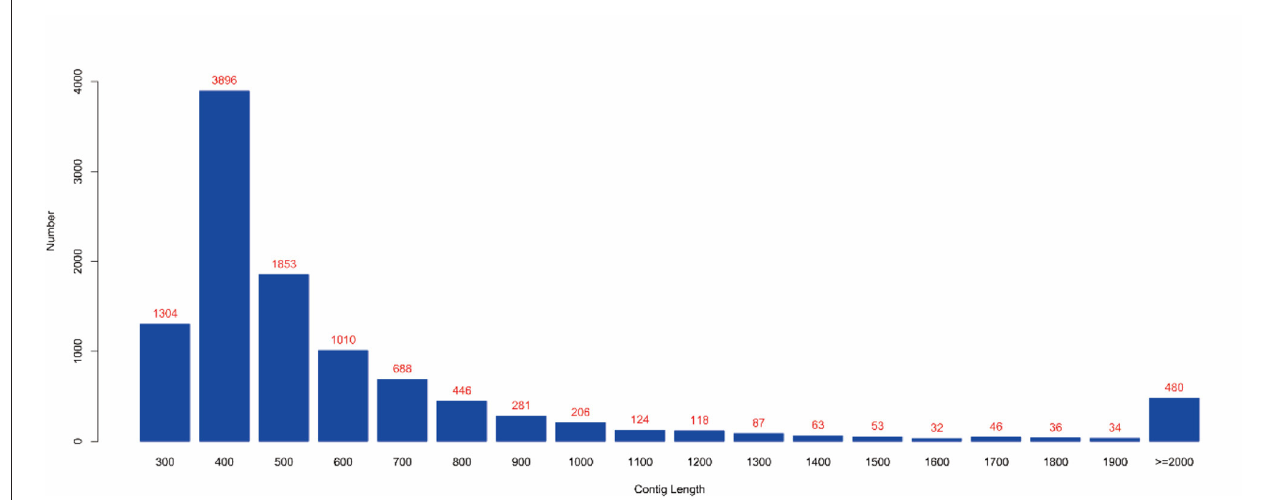
FIGURE 4 | Contig length distribution. (1) The abscissa represents the length of contigs, and the ordinate represents the number of contigs; (2) The red number represents the number of contigs in the length segment.